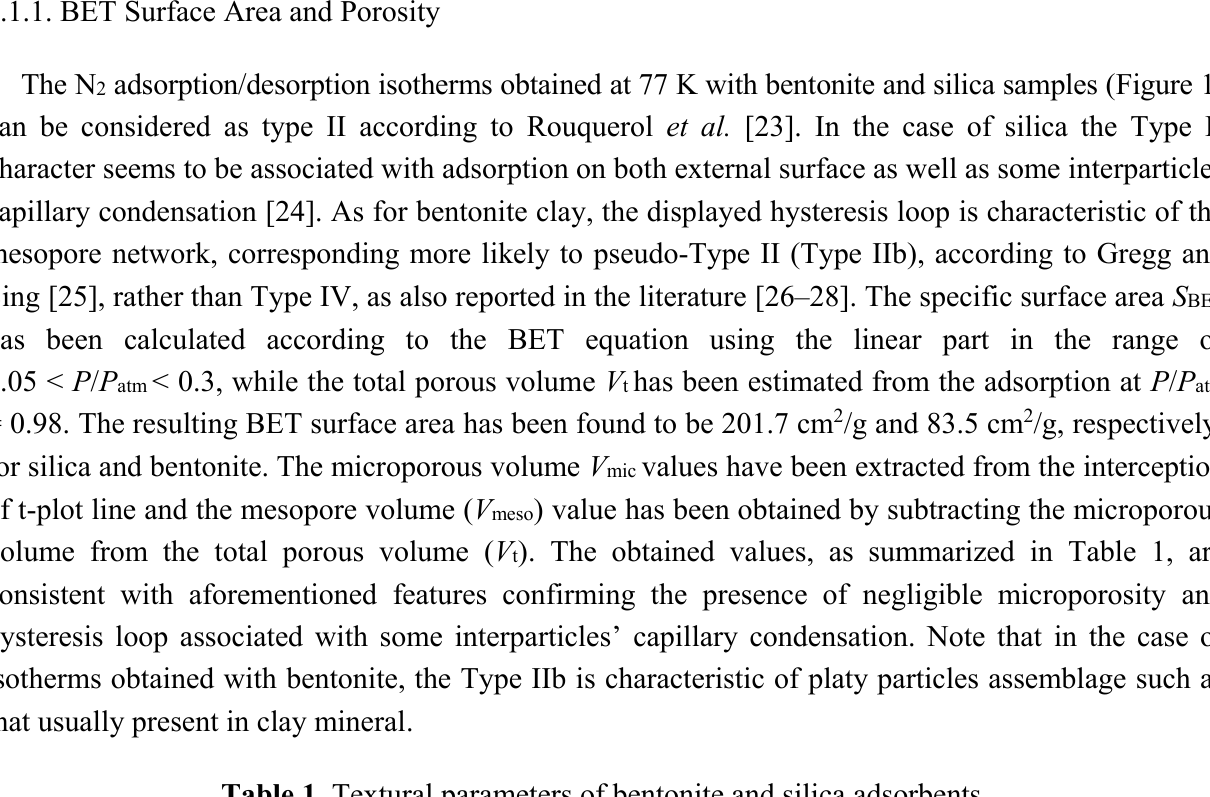
Table 1. Textural parameters of bentonite and silica